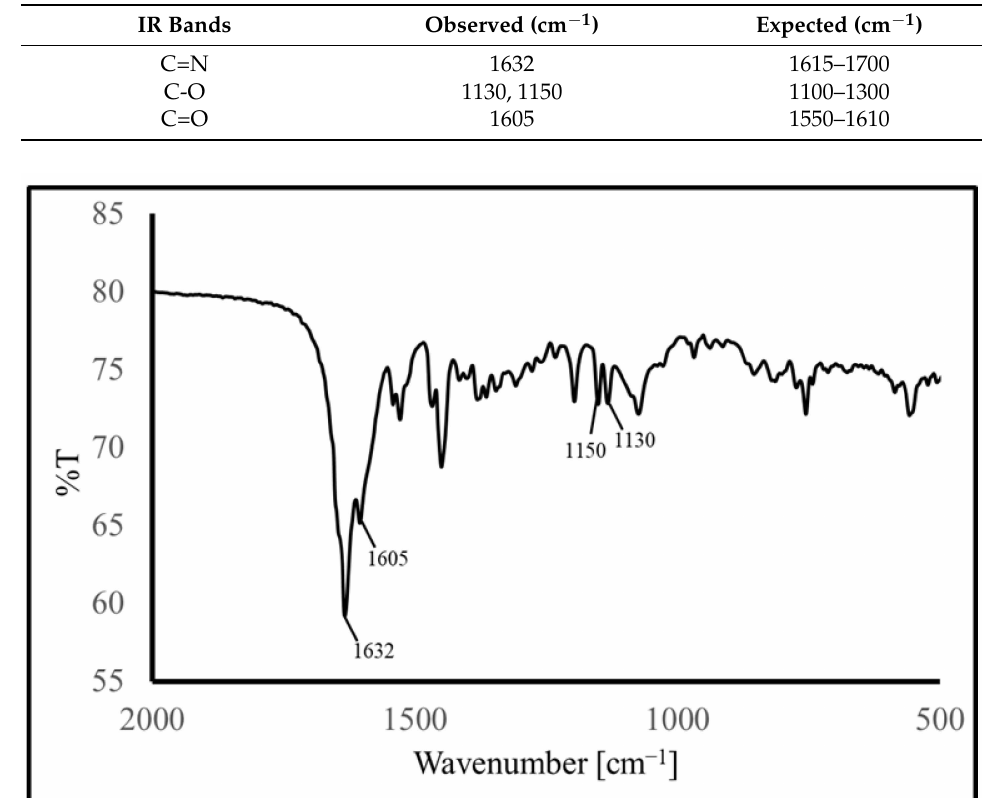
Figure 3. FT–IR spectrum of amino acid Schiff base copper(II) complex.